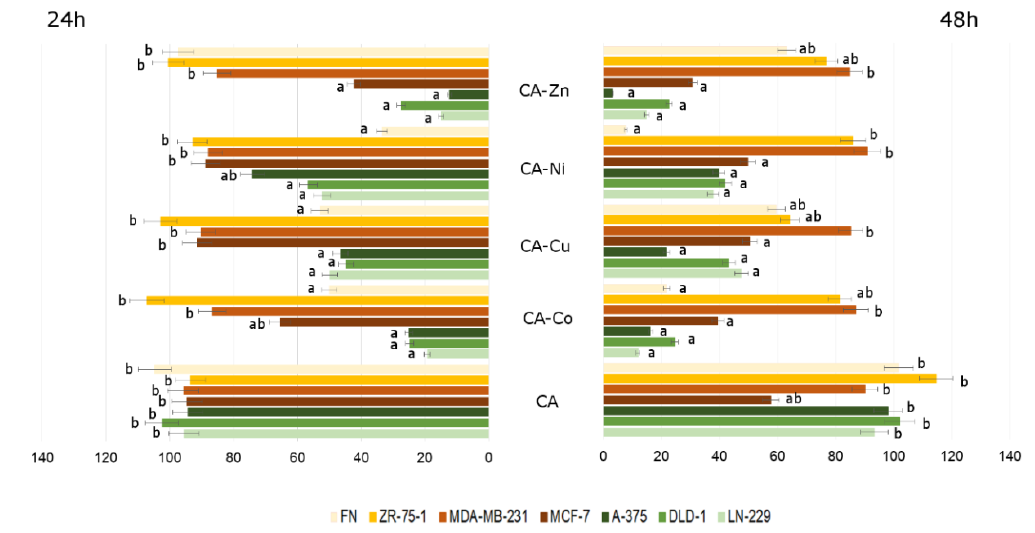
Figure 8. The viability of LN-229, DLD-1, A-375, FN, MCF-7, MDA-MB-231, and ZR-75-1 cell lines treated with di ff erent concentrations of CA and CA–metal (Cu, Zn, Ni, Co) complexes for 24 and 48 h. The results represent means for pooled triplicate values from three independent experiments. Significant alterations are expressed relative to control untreated cells (marked with asterisks). Statistical significance was considered if * p < 0.05.